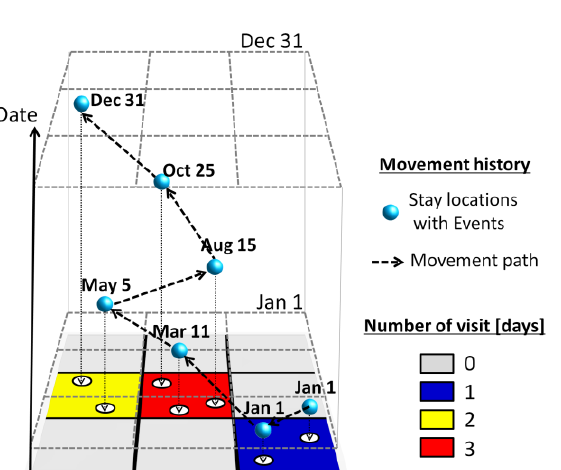
Figure 1. Detection flow of stay location from GPS data